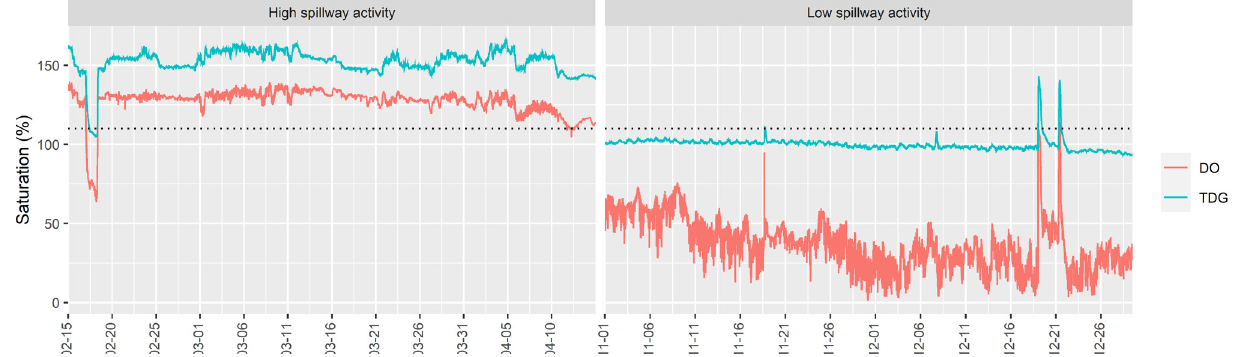
FIGURE 3 | Saturations of dissolved oxygen (DO, red) and total dissolved gases (TDG, blue), for periods with intense (left) and sporadic (right) dam spillway activities. The black dotted line indicates the threshold of 110% TDG